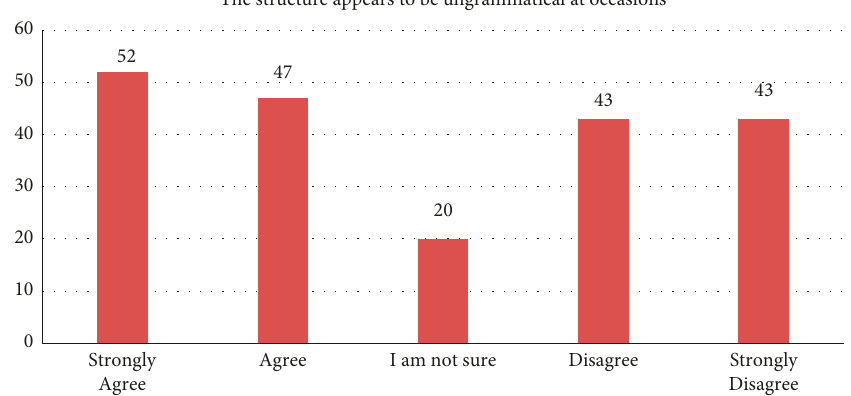
Figure 2: Participants’ responses regarding the grammatical accuracy of the Arabic version of Amazon.sa.